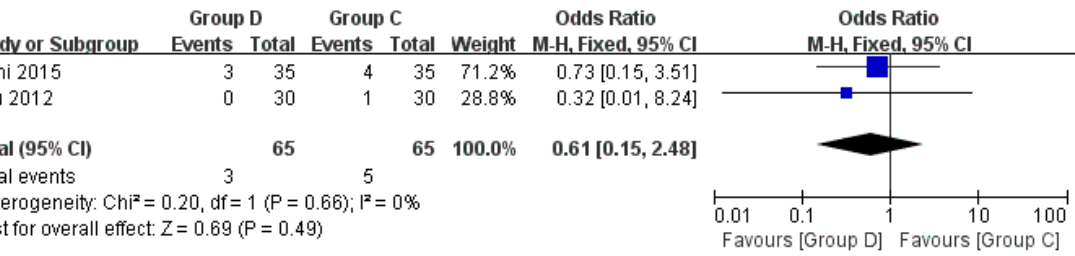
Figure 9. Forest plots comparing the effects of dexmedetomidine and control group on patient satisfaction level [23,24,28–30].